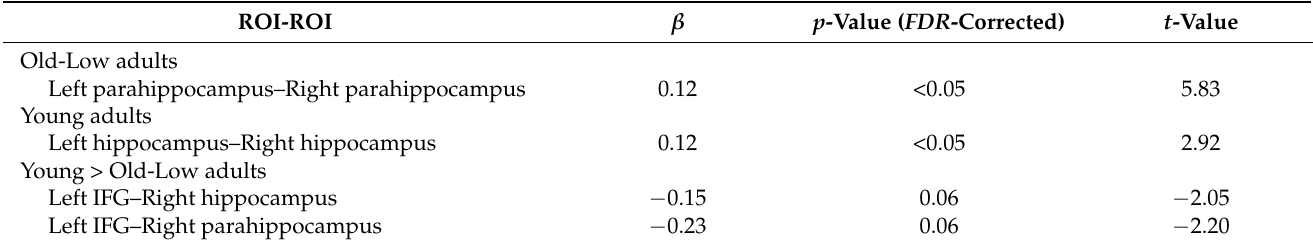
Table 3. Significant ROI-to-ROI functional connectivity for relational encoding of scenes (N > S contrast), at p < 0.05 ( FDR